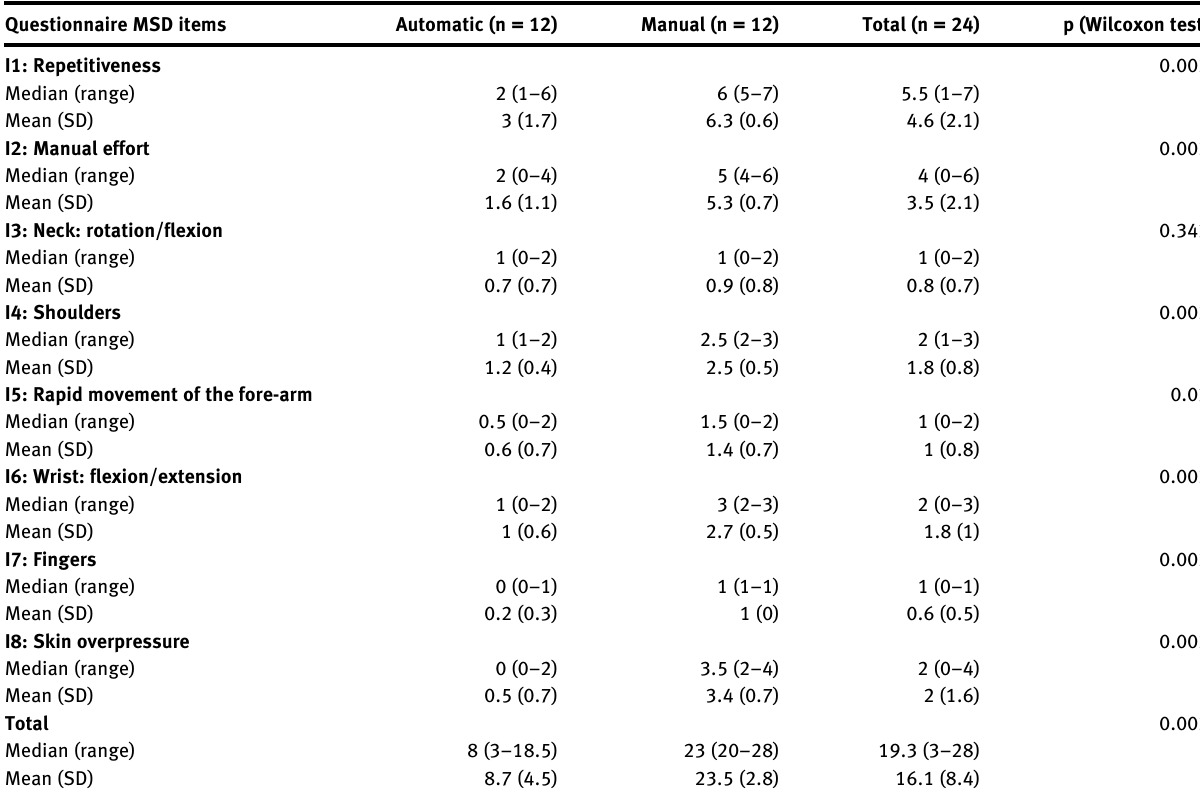
Table  : Questionnaire scores for automatic and manual fi llings and overall. Questionnaire MSD items